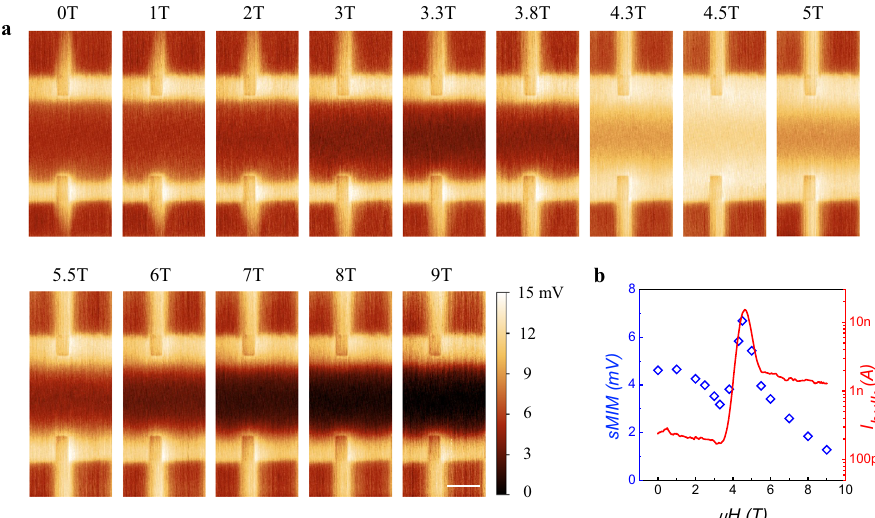
Fig. 3 | Magnetic fi eld dependent sMIM imaging. a Magnetic fi eld dependent sMIM images at +40V gate voltage. The scale bar is 3 μ m. b Field dependent sMIM bulk signals extracted from Fig. 3a. The signal is averaged over the sample interior. Also plotted is the measured bulk current from transport (red solid line).